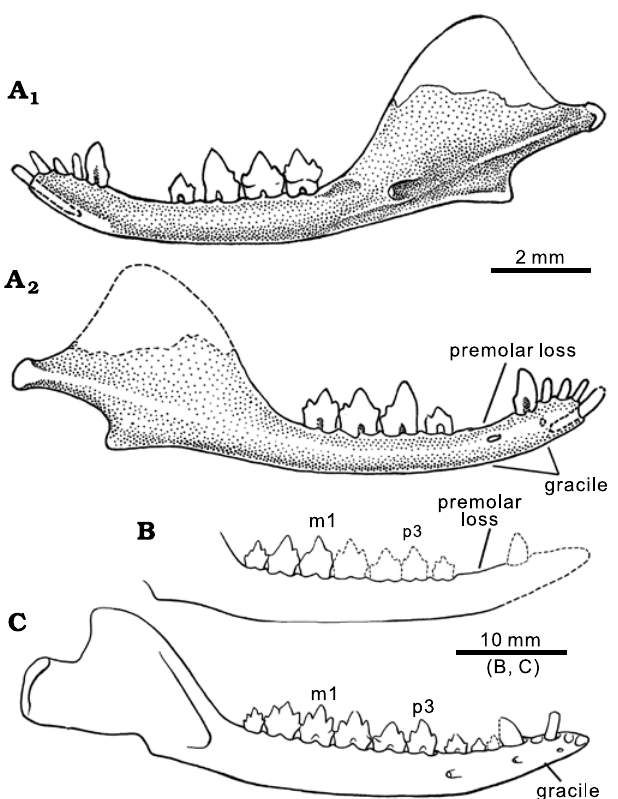
Fig. 1. Lower jaws of comparative mammaliaforms. A . Hadrocodium wui Luo, Crompton, and Sun, 2001 (holotype, IVPP 8275), from the Lower Lufeng Formation, Lower Jurassic of Yunnan, China. Right mandible in lingual (A 1 ) and labial (A 2 ) views. B , C . Morganucodontan Dinnetherium nezorum Jenkins, Crompton, and Downs, 1983, from the Kayenta Formation, Lower Jurassic of Ari zona, USA. B . An older adult (MCZ 20910). C . A young adult (MCZ 20870); modified from Crompton and Luo 1993). Younger individuals of D. nezorum have a full set of five premo- lars, while older individuals have lost up to two anterior premolars without replacement. The postcanine diastema developed by shedding premolars without replacement is an aging-related character of many mammaliaforms including Hadrocodium